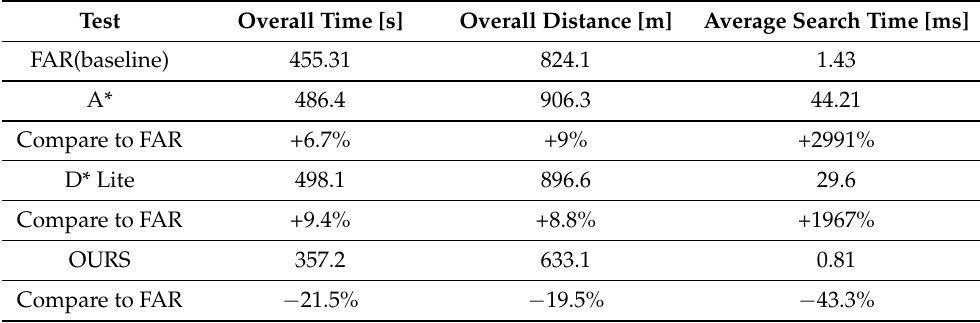
Table 2. The overall time spent by the robot using different algorithms in [s] in Indoor environment.